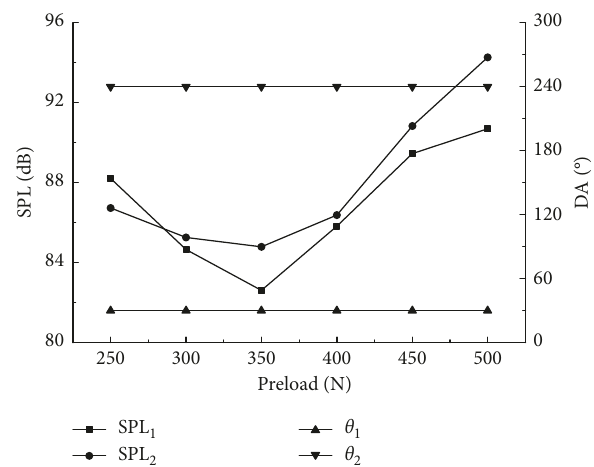
Figure 4: Variation trends of DAs and their SPLs with preload.